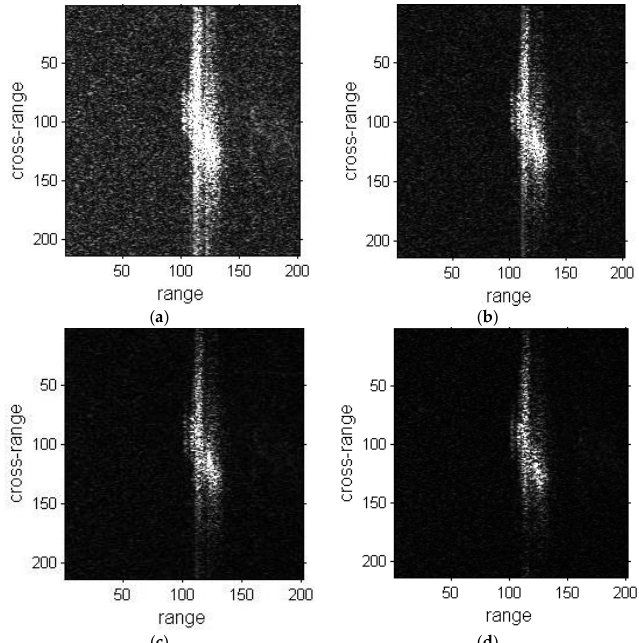
Figure 16. Refocused images of ship05 sub-image. ( a ) Sub-image of ship05; ( b ) Refocused image with the DCT method; ( c ) Refocused image with the PGA method; ( d ) Refocused image with the proposed method.